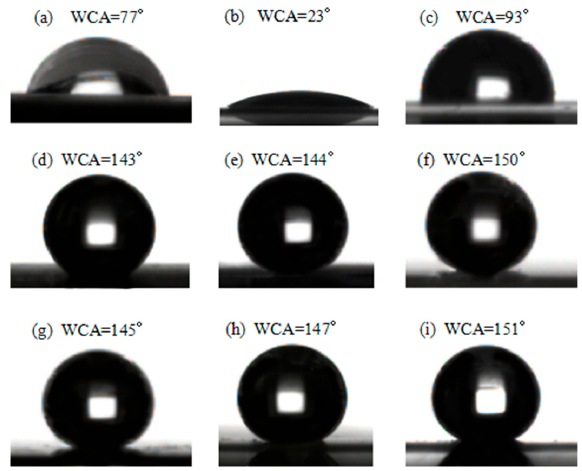
Figure 7. Apparent water contact angle (AWCA) images of ( a ) M 1 , ( b ) M 2 , ( c ) M 3 , ( d ) M 1 -1, ( e ) M 2 -1, ( f ) M 3 -1, ( g ) M 1 -3, ( h ) M 2 -3, ( i ) M 3 -3.